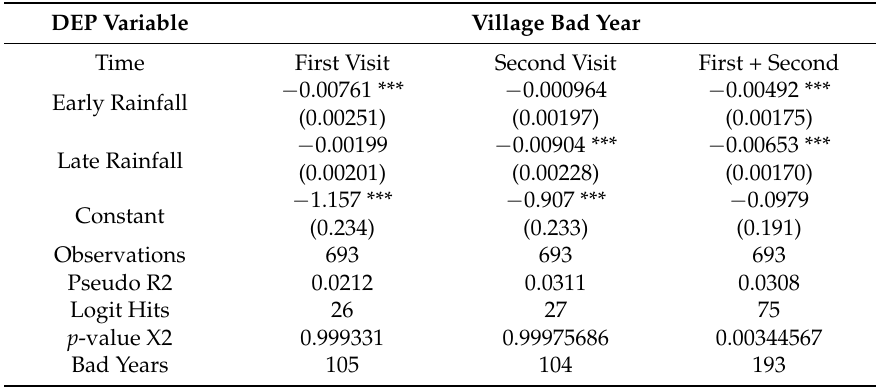
Table 2. Village level results aggregating first and second visits (21 villages).